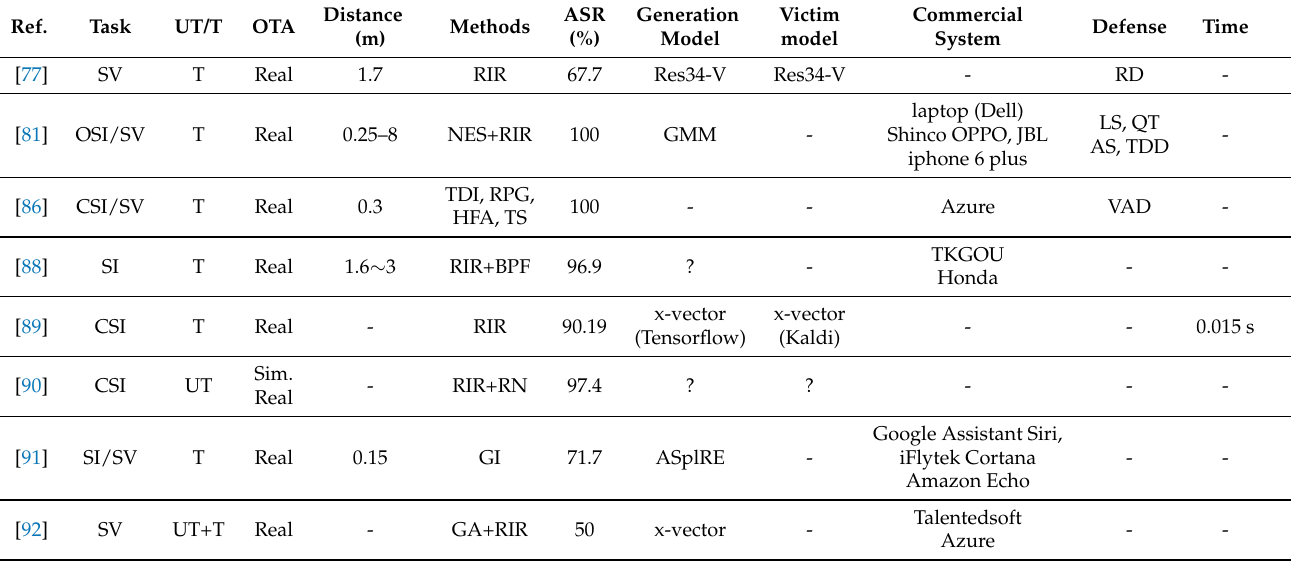
Table 4. Related works on adversarial attacks for physical